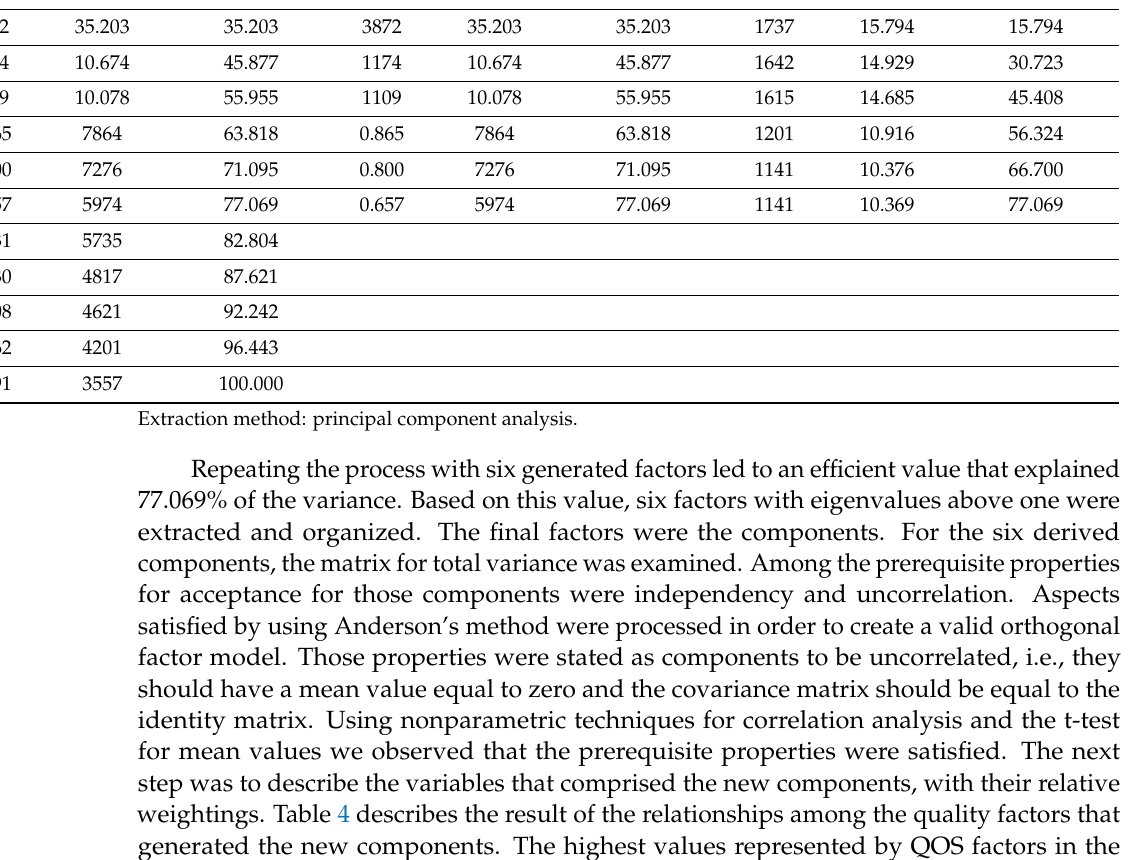
Table 4. Rotated component matrix of scores of Q Ο S factors to the generated components.